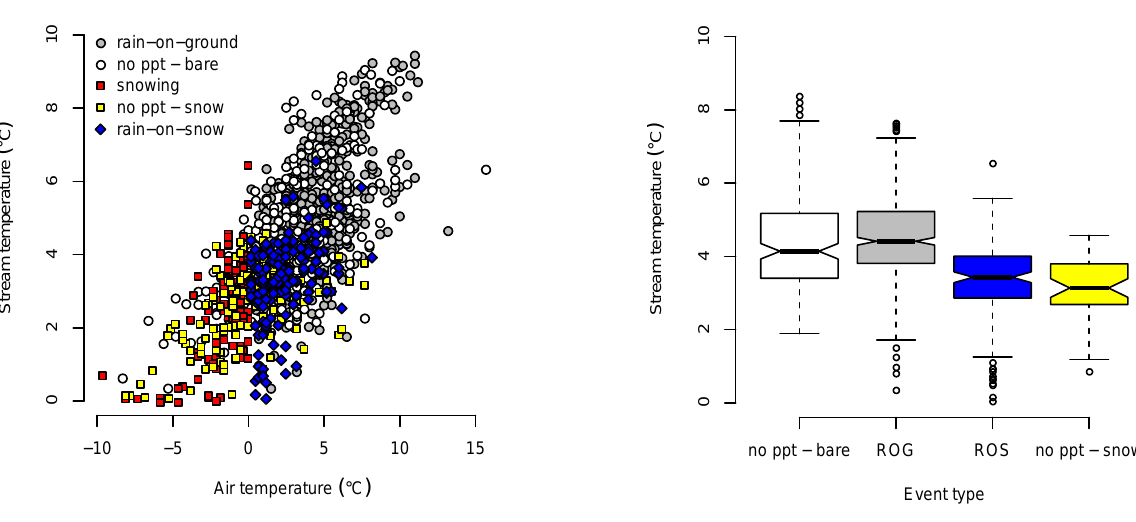
Fig. 11. Boxplots of mean daily stream temperature at East Creek during periods of mean daily air temperature between 0 and 5 ◦ C for four different event types: (1) no precipitation with bare ground, (2) rain on bare ground (ROG), (3) rain on snow (ROS), and (4) no precipitation with snow